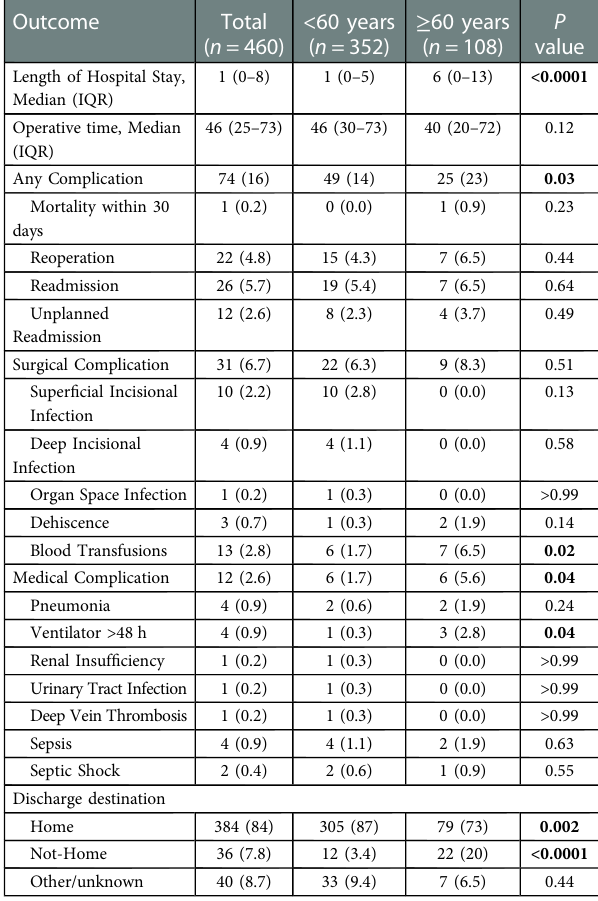
TABLE 3 Comparison of outcomes following burn surgery between patients younger and older than 60 years of